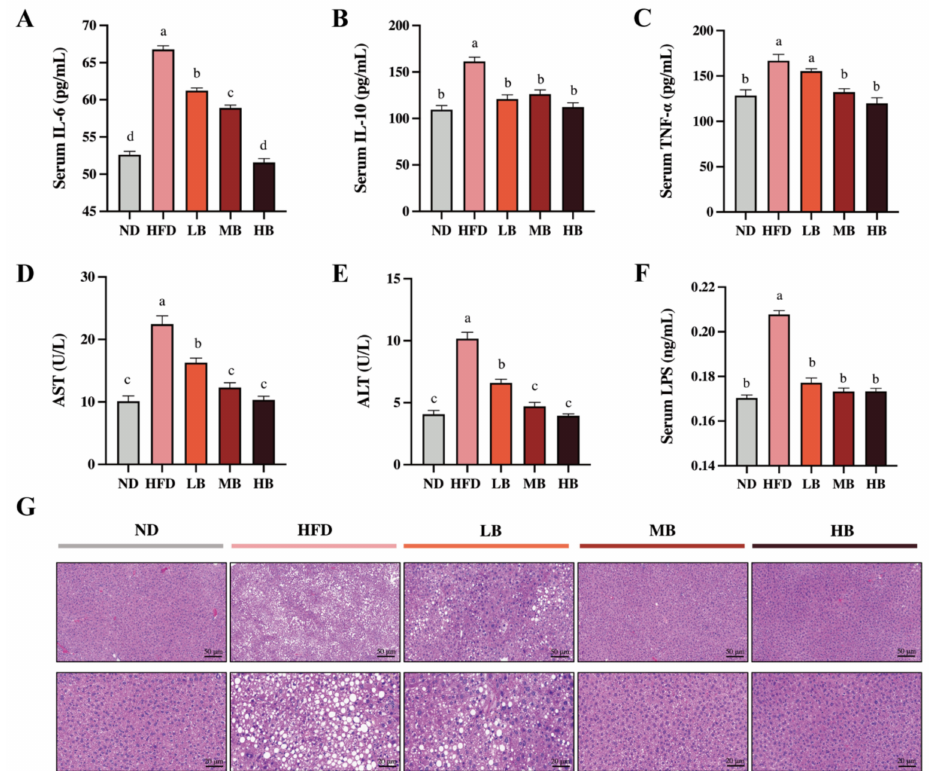
Figure 2. Effects of tartary buckwheat on HFD-induced low-grade inflammation and hepatic steatosis. ( A ) Serum IL-6 levels. ( B ) Serum IL-10 levels. ( C ) Serum TNF- α levels. ( D ) Serum AST levels. ( E ) Serum ALT levels. ( F ) Serum LPS levels. ( G ) Representative images of histological sections of liver tissue (scale bar, 50 µ m and 20 µ m). Data are expressed as the mean ± SEM ( n = 8). The mean value with different letters indicates significant differences ( p <